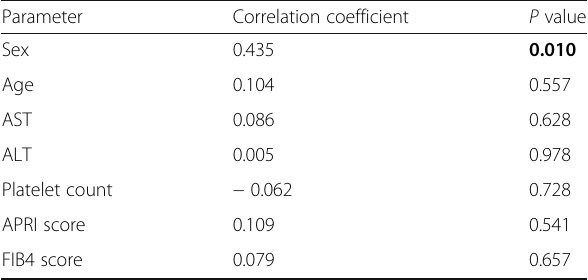
Table 7 Correlation between ATX and baseline parameters: it showed only a statistically significant correlation between ATX and sex. No correlation exists between ATX and other parameters